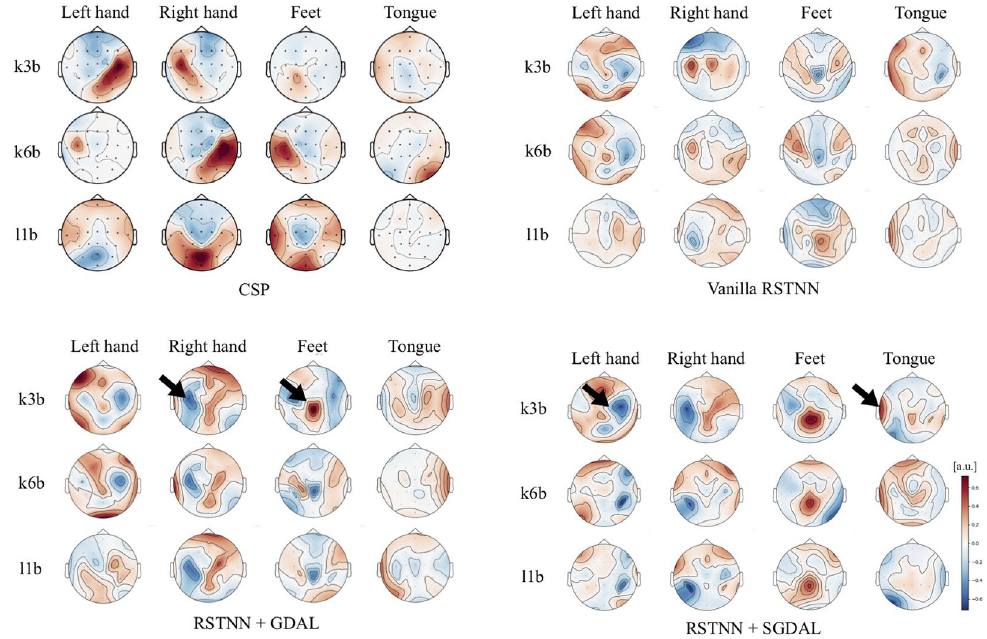
Figure 4. Activation pattern maps for the learned spatial filters in CSP (left top), the learned spatial kernel weights in RSTNN 12 (right top), the learned spatial kernel weights in RSTNN + GDAL (left bottom), and the learned spatial kernel weights in RSTNN + SGDAL (right bottom). Each column is related to a class, i.e., left- hand, right-hand, feet, and tongue, and each row denotes a subject